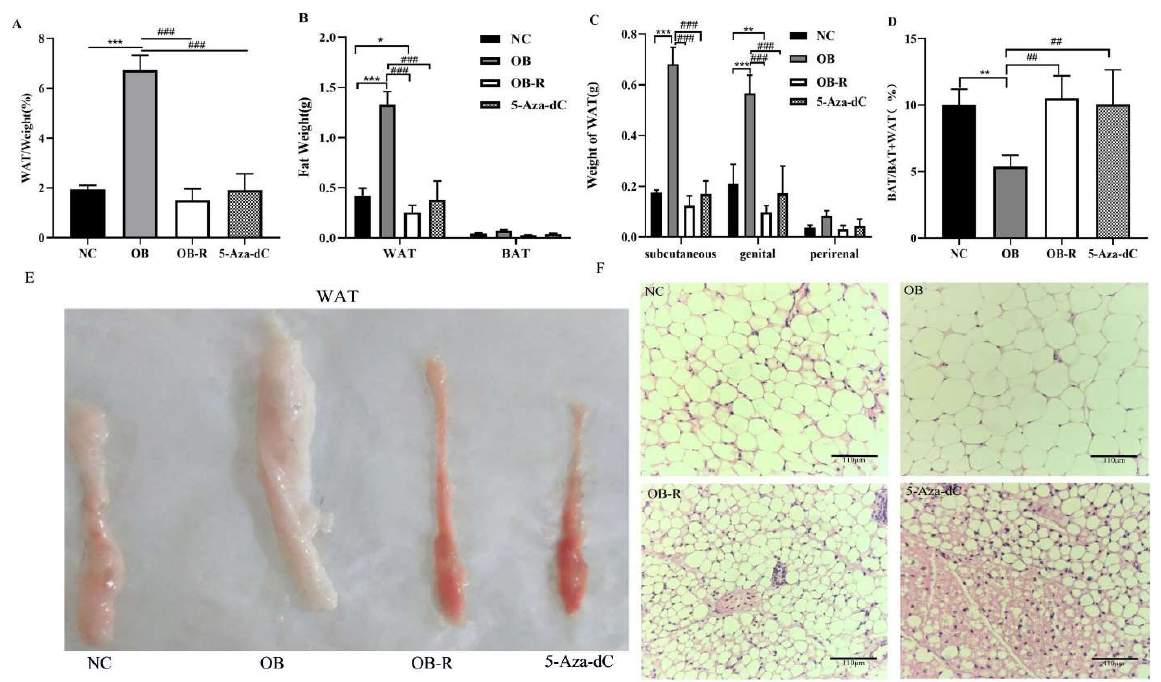
Figure 3. Detection of the subcutaneous adipose tissue in mice after 5-Aza-dC treatment. ( A ) Body fat percentages of the four groups are presented as the mean ± SD (n = 5); ( B ) Fat weights of mice in the four groups are presented as the mean ± SD (n = 5); ( C ) WAT distribution in mice in the four groups is presented as the mean ± SD (n = 5); ( D ) The proportion of brown fat weight to total fat weight in the four groups, presented as the mean ± SD (n = 5). ( E ) Pictures of subcutaneous white adipose tissue of the four groups; ( F ) H&E staining in the inguinal subcutaneous WAT of mice induced by MSG (scale bar = 110 µm). * p < 0.05; ** p < 0.01; *** p < 0.001 vs. the NC group; ## p < 0.01; ### p < 0.001 vs. each other group. NC, normal control; OB, MSG-induced obese mice; OB-R, MSG- induced obesity-resistant mice; 5-Aza-dC, 5-aza-2 (cid:48) -deoxycytidine-induced DNA demethylation mice; WAT, white adipose tissue; BAT, brown adipose